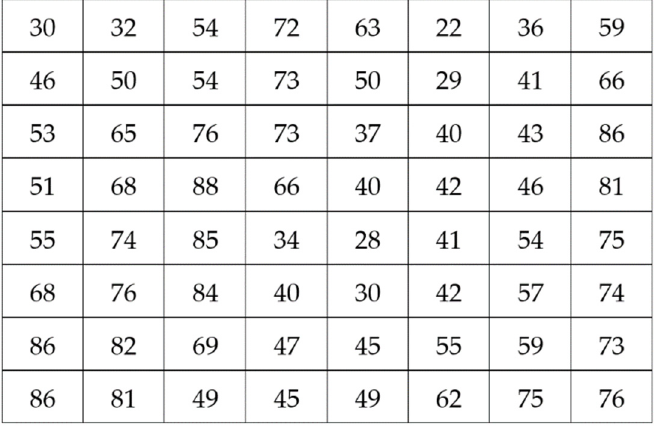
Figure 3. Luminance values for an 8 by 8 block of pixels. If representing graphically the luminance values, a histogram is obtained, shown in Figure 4.